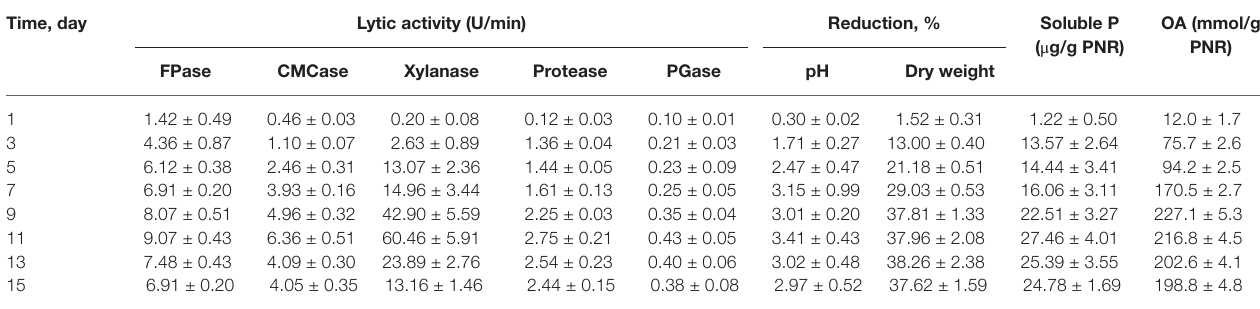
TABLE 1 | Time course profile of PNR biodegradation for organic acid production in association with cellulolytic activity and TCP solubilization by Trichoderma sp. WKA55 grown on a PNR-based fermentation medium. Time, day Lytic activity